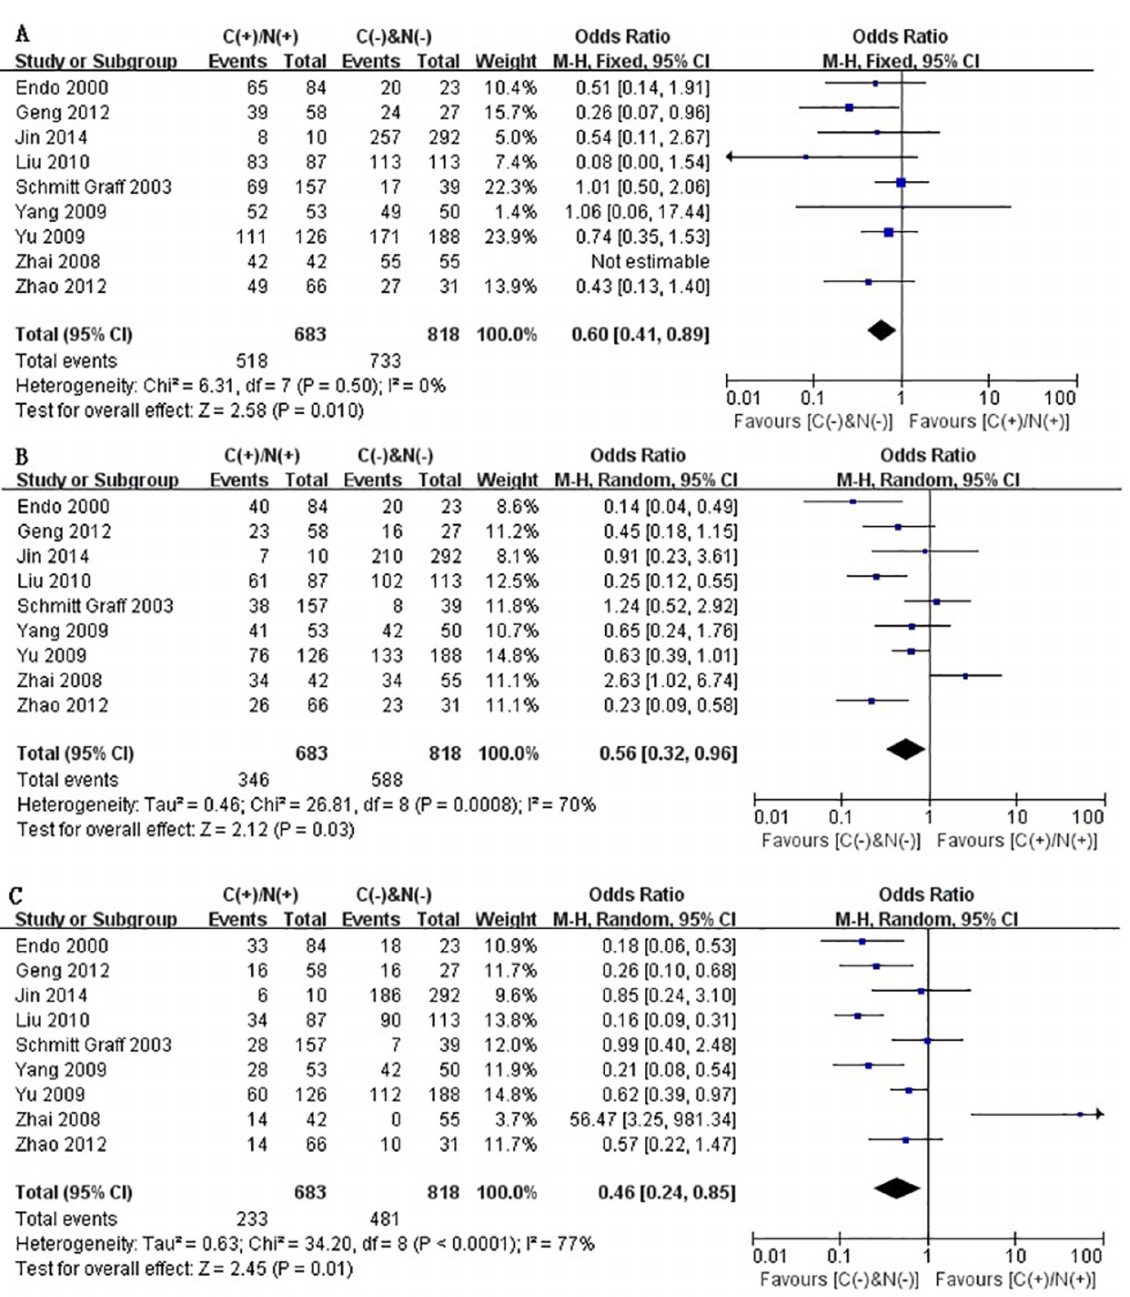
Figure 2. Forest plot of odds ratio for the association of b -catenin expression in cytoplasm and/or nucleus with 1-year (A), 3-year (B) and 5-year (C) overall survival.